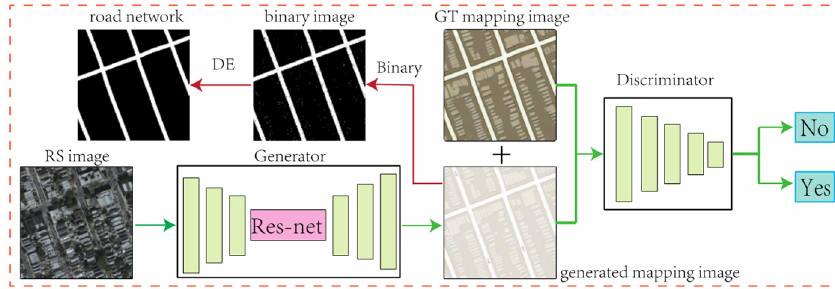
Figure 1. Road extraction network structure.